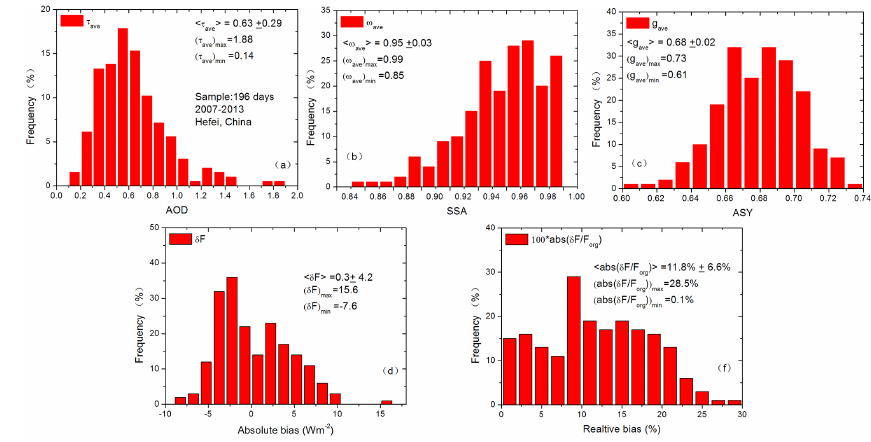
(cid:16) δF (cid:17) selected in SKYNET Hefei site from 2007 to 2013. F org